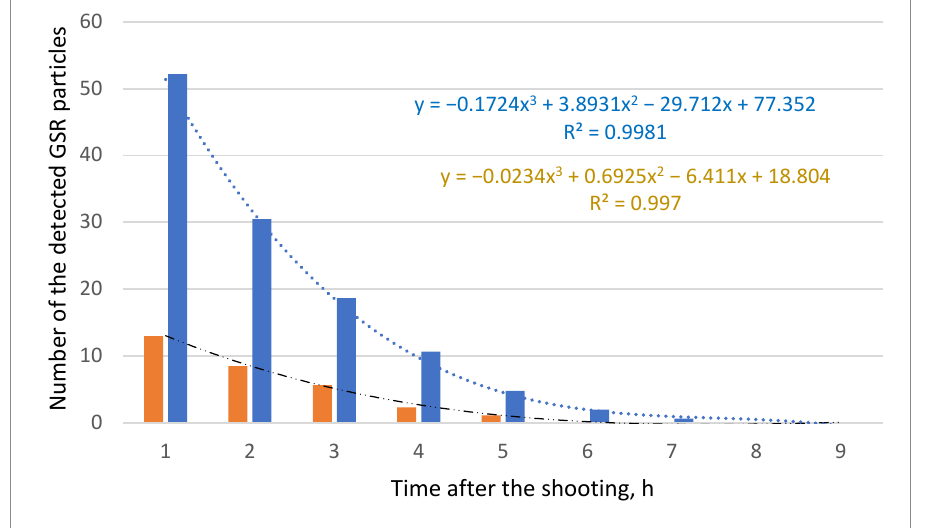
Figure 5. Mean number of particles characteristic of GSR as a function of the time interval between shooting and sampling: (blue) high-caliber ammunition and (orange) low-caliber ammunition. The mean values were calculated from six series of experiments with six firearms (three from each caliber) during two seasons. The polynomial equations are presented in the inset.